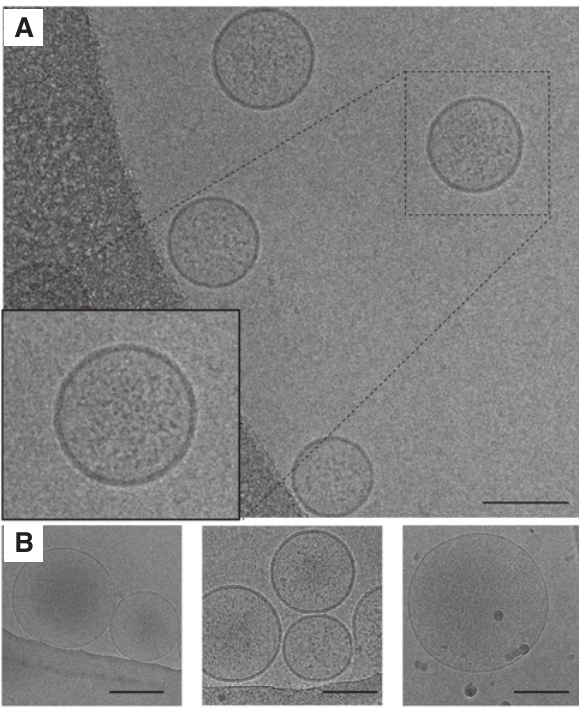
Figure 4: Cryo-EM images of liposomes encapsulating bovine serum albumin (BSA). E. coli polar lipid extract liposomes were formed in 20 mm Tris-HCl pH 7.6, 1 mm EDTA buffer containing the indicated amount of BSA and dispersed in the same buffer without it. (A) BSA, 33 mg/ml. (B) BSA, 5 mg/ml (left), 10 mg/ml (middle), 50 mg/ml (right). The concentration of BSA in the starting buffer had to be 10 mg/ml or more for encapsulation to be visible. Scale bars: 100 nm.